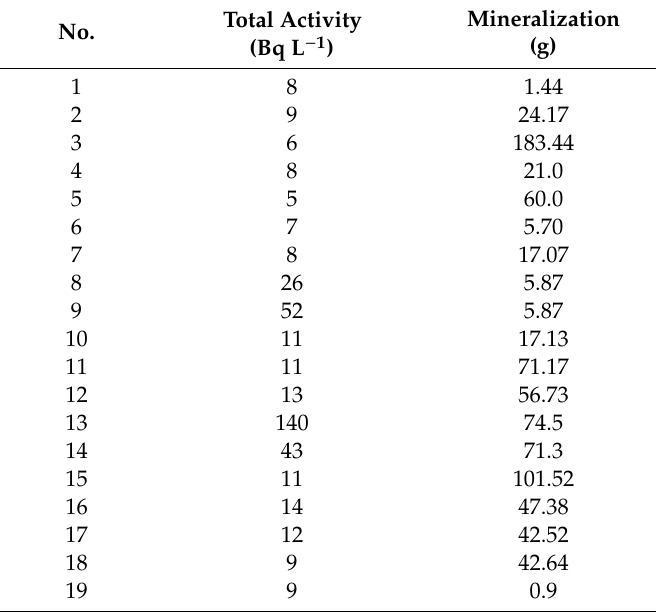
Table 2. Total activity and mineralization of mineral water samples. Total Activity No. (Bq L − 1